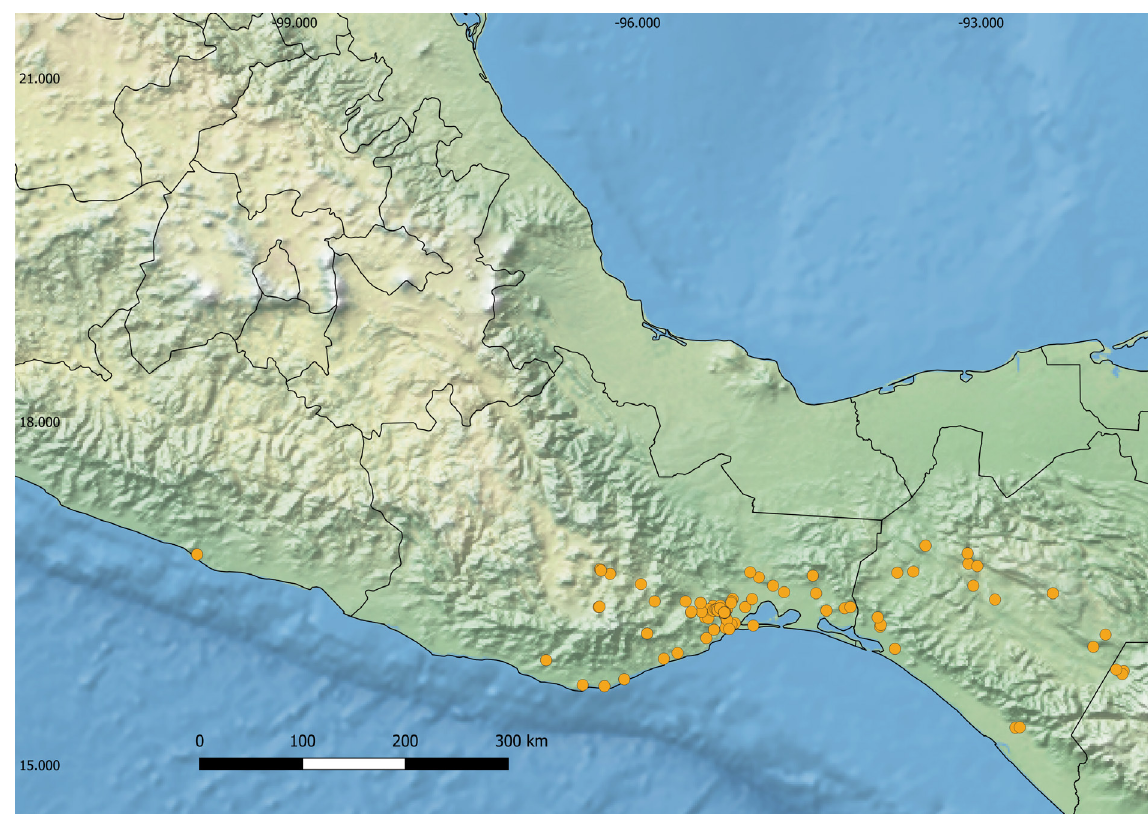
Fig. 3. Locality records of Salvadora lemniscata (Cope,